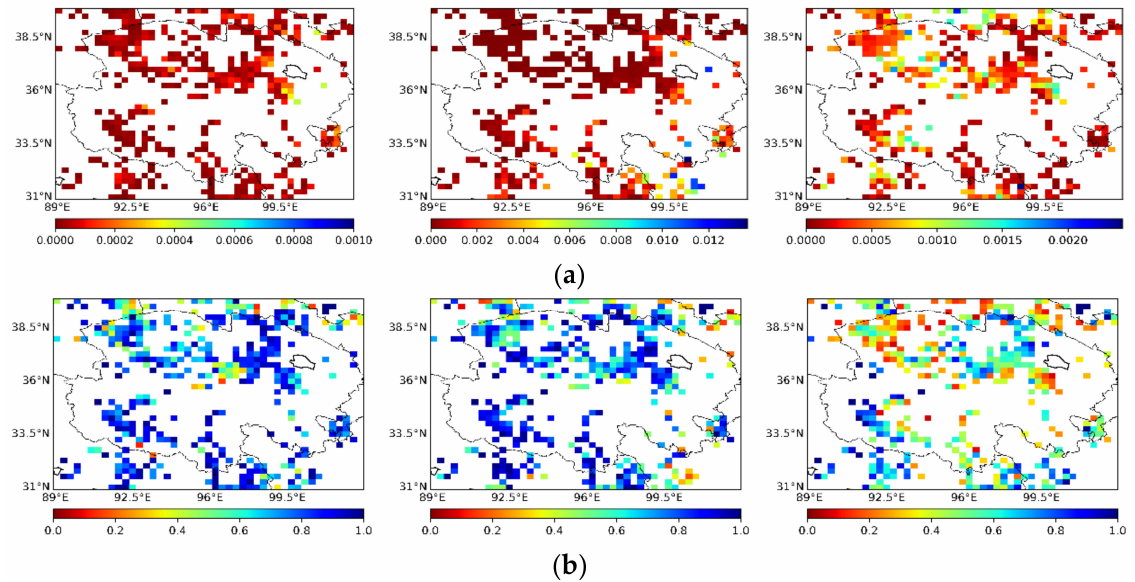
Figure 7. ( a ) Top row from left to right, Map of error variance for NN SM, FY3C SM, and GEOS-5 SM compared with actual SM data. ( b ) Bottom row from left to right, Map of correlation coefficient for NN SM, FY3C SM, and GEOS-5 SM compared with actual SM data.